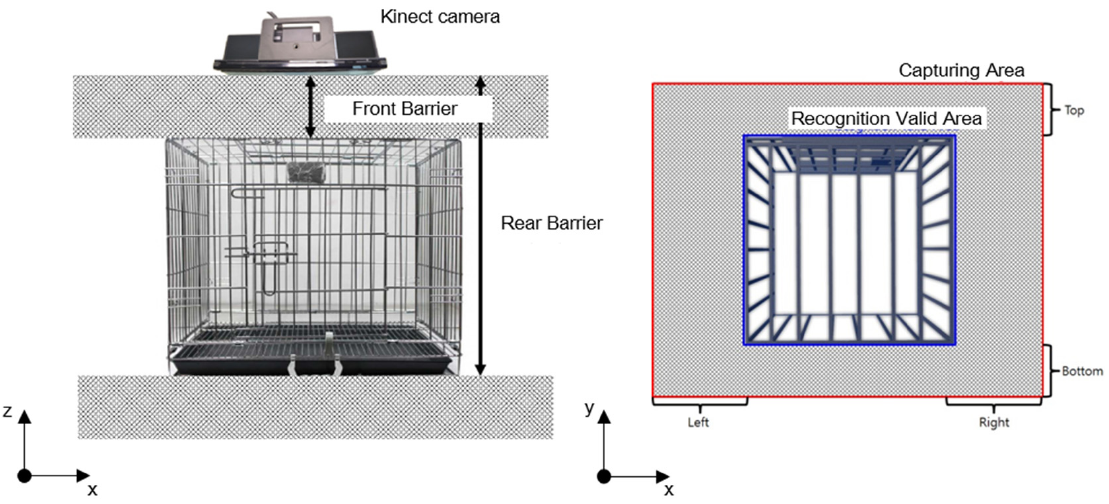
Figure 2. A three dimensional R.O.I selection inside a cage. 4. In order to select the ROI inside a cage in the z-y plane, image data outside a cage were eliminated. The removal area is shown as a grey rectangular box in which each side is denoted as “Top,” “Bottom,” “Left,” and “Right” (Figure 2). Figure 1b depicted processed images after applying step 3 and step 4 to raw images; 5. Noise reduction: after recording 30 frames of image data, the pixels which underwent a small change equal to the specified value were removed (Figure 3a). Then, the “blur” function was used to eliminate minor noise in the image data (Figure 3b). The minor noise is defined as unnecessary pixels for object identification and disregarded for enhancing following image processing